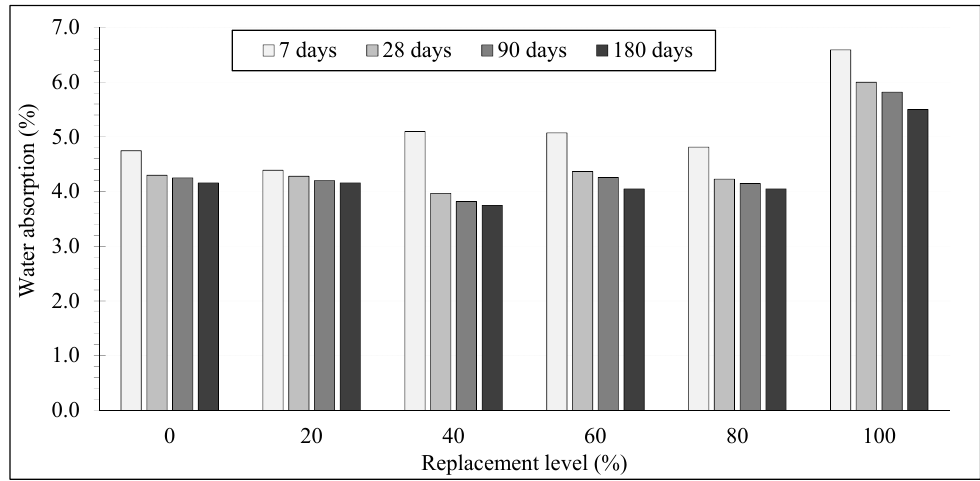
Figure 27. Water absorption of POCP concrete at different ages.